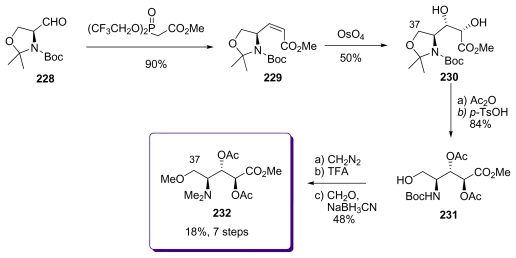
Preparation of 232.